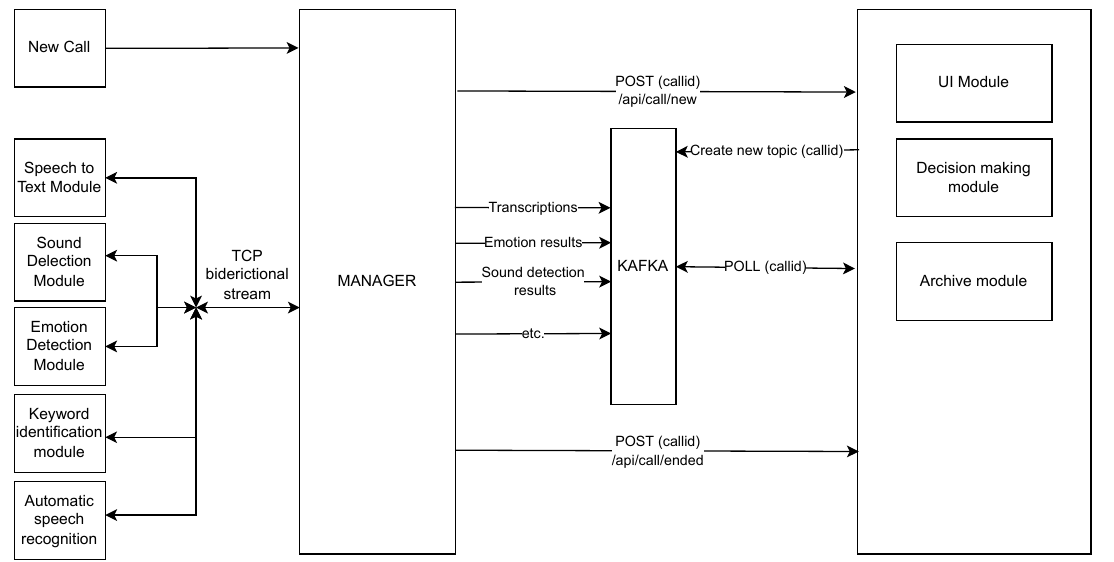
Figure 5. ODIN112 Architecture: Communication and integration of